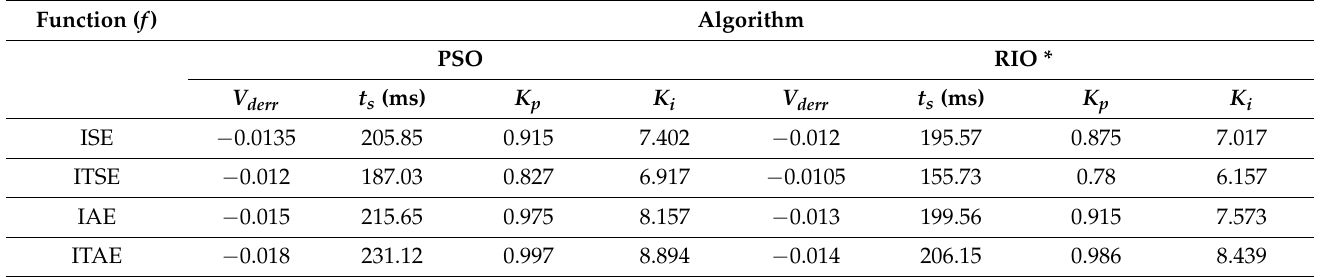
Table 7. Comparative performance indices for different objective